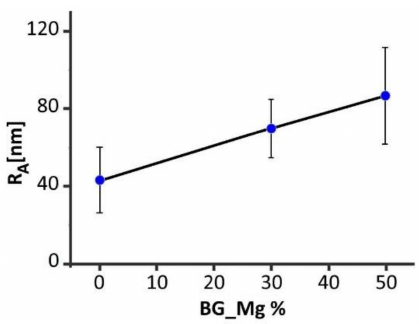
Figure 5. Roughness (R A ) values in correspondence with the three formulations, i.e., pure PCL, 70/30, and 50/50.